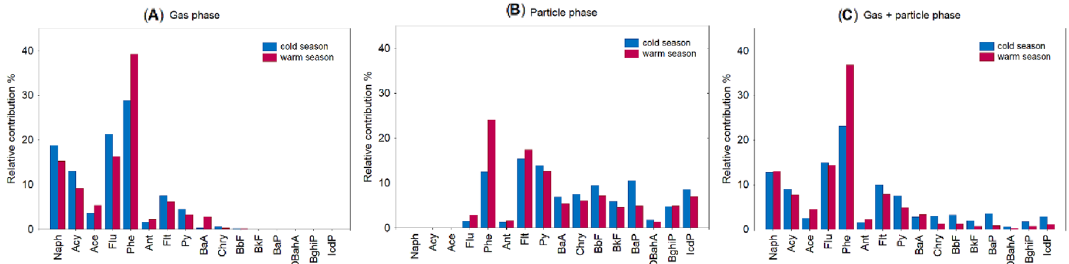
Figure 4. Comparison between two periods (warm and cold) for PAH congener contributions (%) related to ( A ) gas phase, ( B ) particle phase, and ( C ) gas + particle